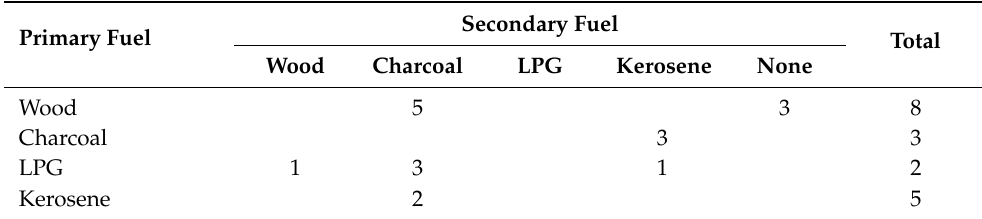
Table A1. Distribution of primary and secondary fuels in households recruited for air quality monitoring.